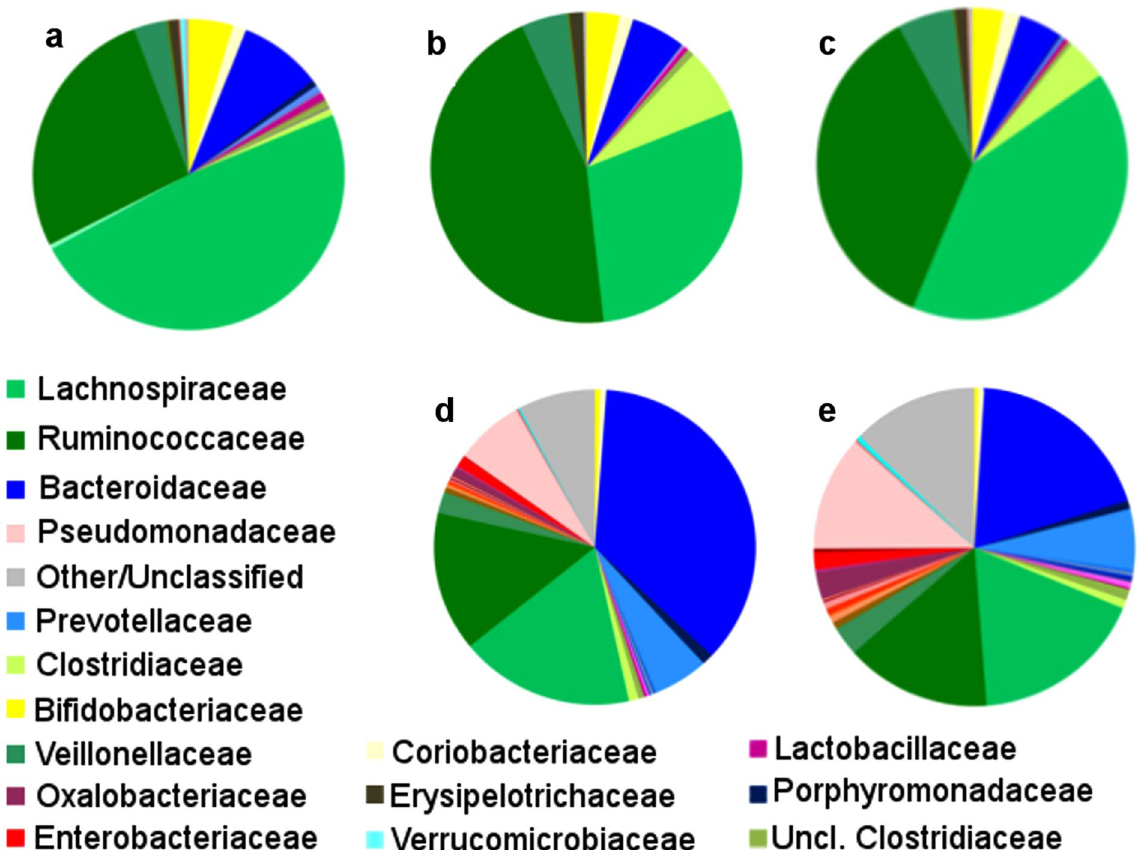
Figure 5. Median fecal microbiota composition at family level in (a) healthy adults, (b) UC patients at T0, (c) UC patient at T3 and colon biopsies of (d) UC patients at T0 and (e) UC patients at T3, represented as pie chart, in available samples from compliant and responder patients. Average relative abundance of families representing at least 0.2% of the total microbiota in at least 10% of the sequenced samples are showed. Color code for the most abundant bacterial families (present at an average abundance > 1% in at least one group of samples) is reported in approximate decreasing abundance order. Mann-Whitney U test was used to test differences among median